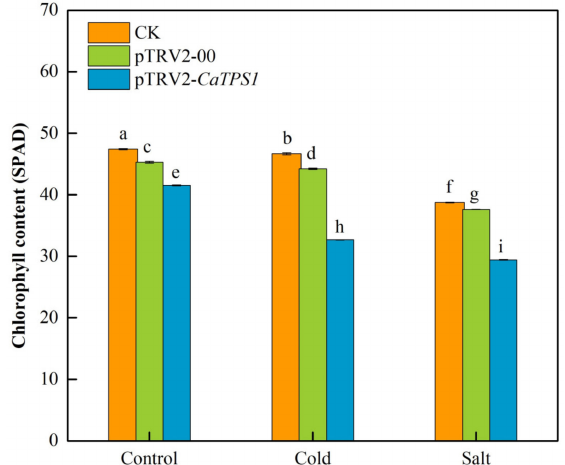
Figure 5. The chlorophyll content under cold and salt stresses. Each value is shown as the mean ± standard error of three biological replicates, and the multiple comparison tests for each gene was presented. Different letters stand for significant differences between CK, pTRV2-00, and pTRV2- CaTPS1 plants (Duncan’s test, p <